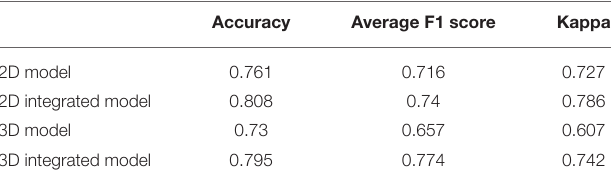
TABLE 4 | Performance comparison for three-class classification of brain atrophy in test set, in terms of accuracy, average F1 score, and Weighted kappa